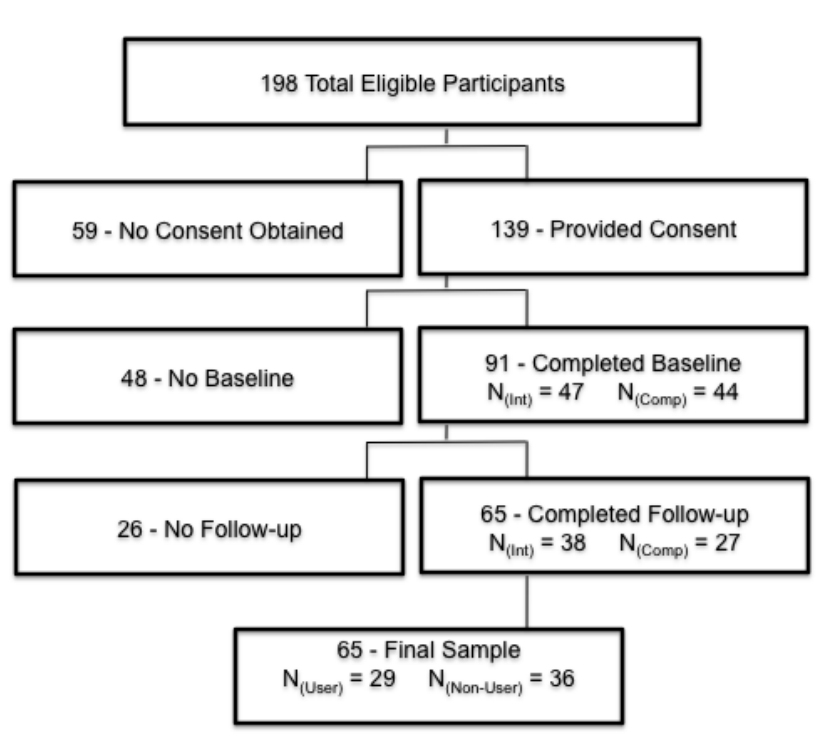
Figure 3. Detailed breakdown of participant